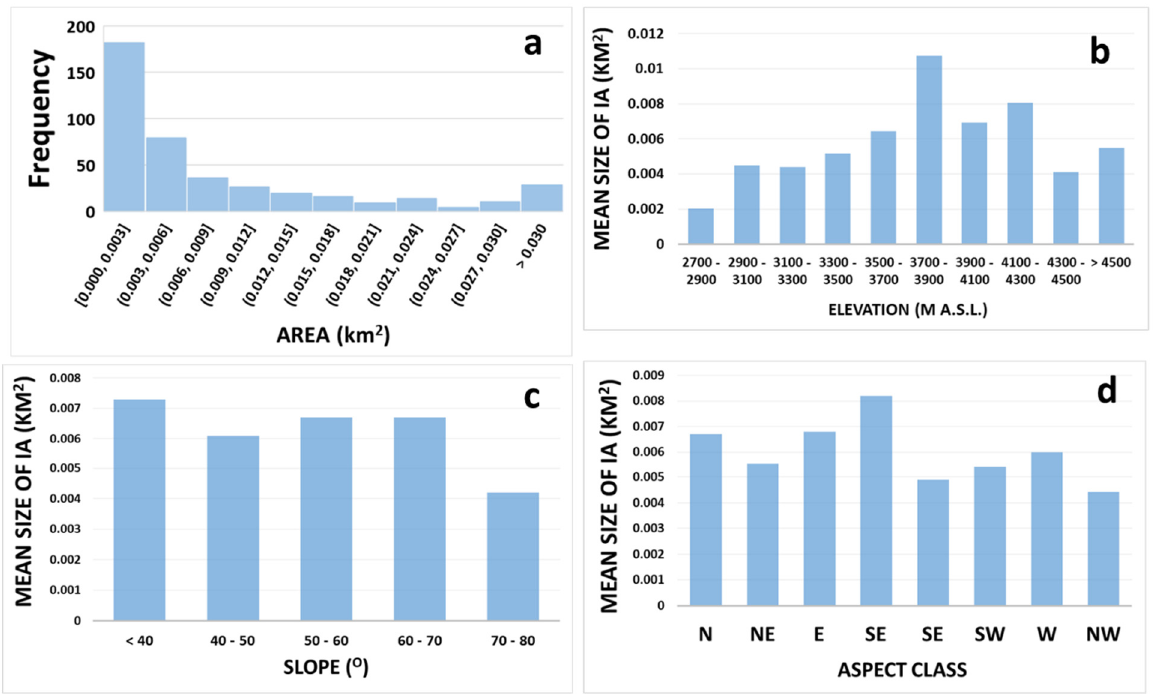
Figure 10. ( a ) Frequency distribution of the IAs; comparison of the IAs mean area with ( b ) elevation, ( c ) aspect, and ( d ) slope angle.